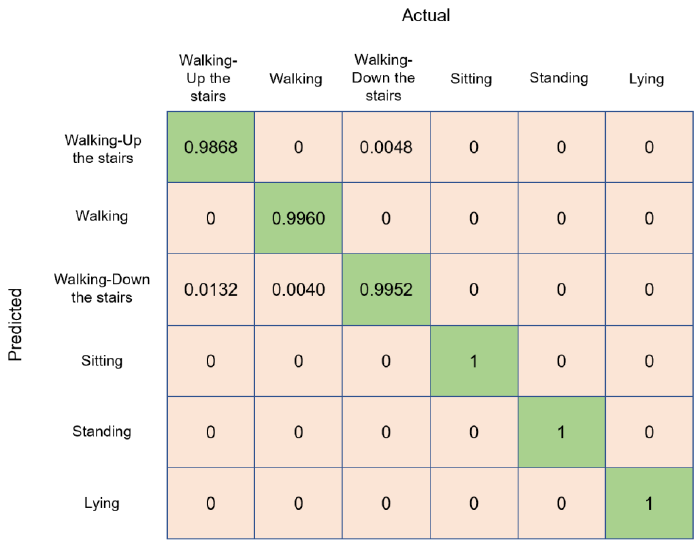
Figure 8. Normalized confusion matrix of the AdaBoost method.